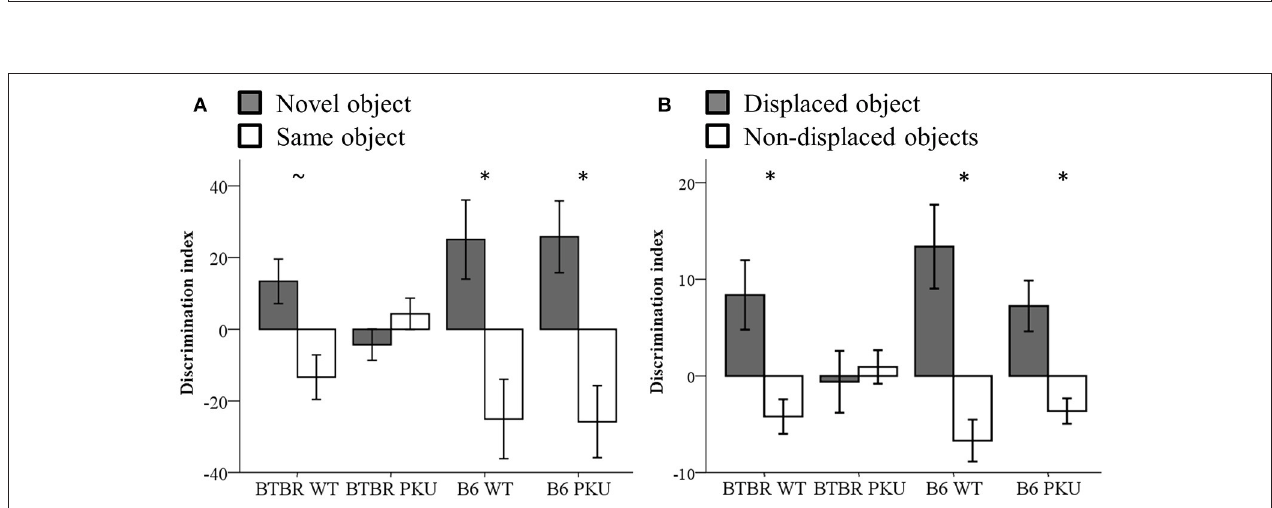
FIGURE 7 | Learning and memory. (A) Discrimination index of NOR ( n = 10). (B) Discrimination index of SOR ( n = 8–10). * p ≤ 0.05, ∼ p = 0.06; mean ± SEM.